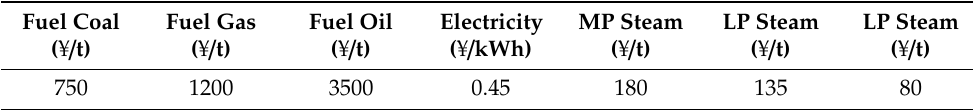
Table 5. The unit price of resources.